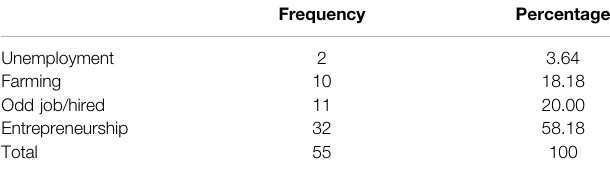
TABLE 3 | Original occupation of the current entrepreneurs.